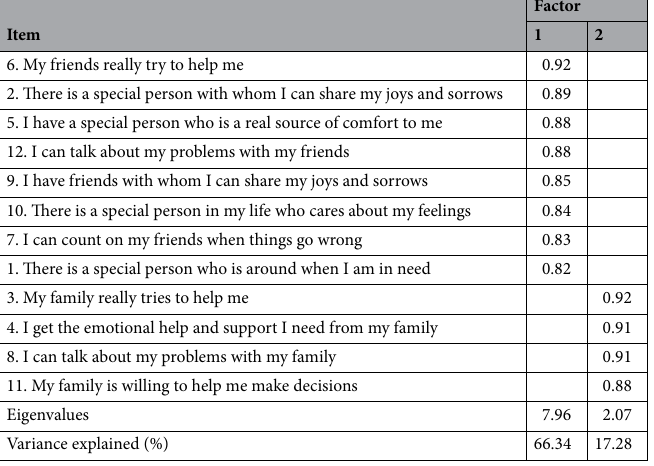
Table 4. Rotated factor matrix of MSPSS-C based on the principal component analysis with varimax rotation.